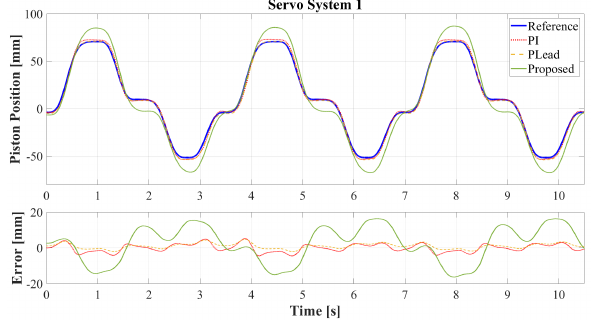
Figure 7: Tracking performance comparison of the pro- posed and reference controllers for servo sys- tem 1, faster trajectory.